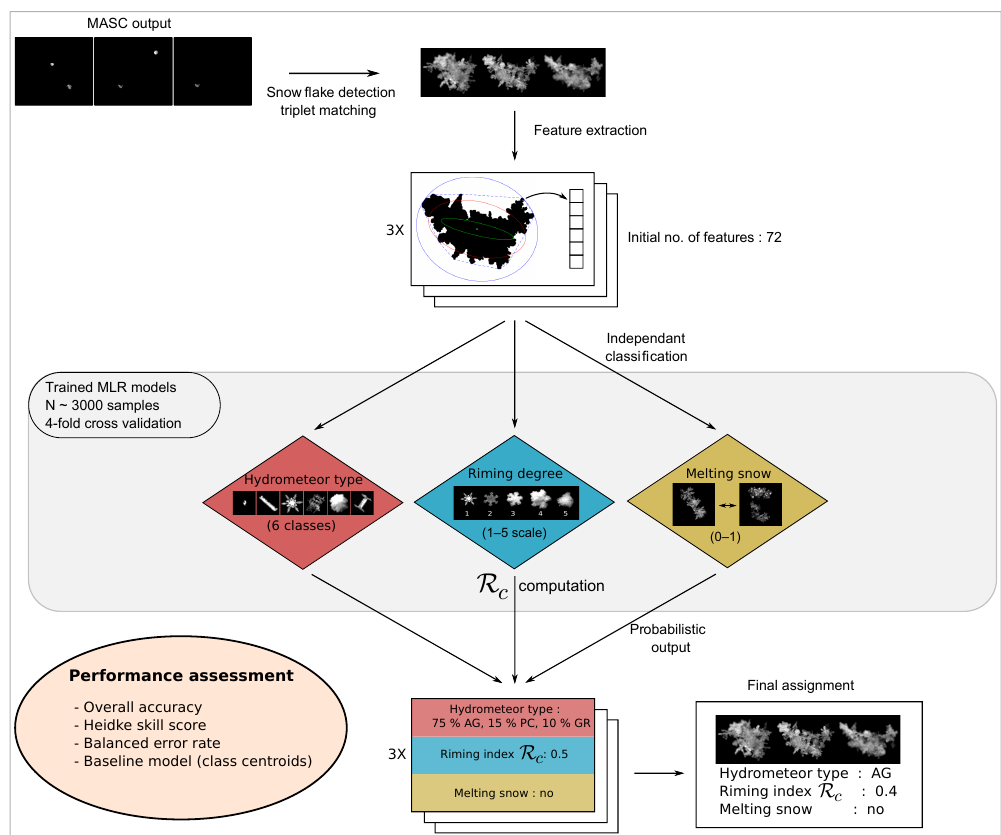
Figure 4. Classification procedure for a triplet of images obtained with the MASC.